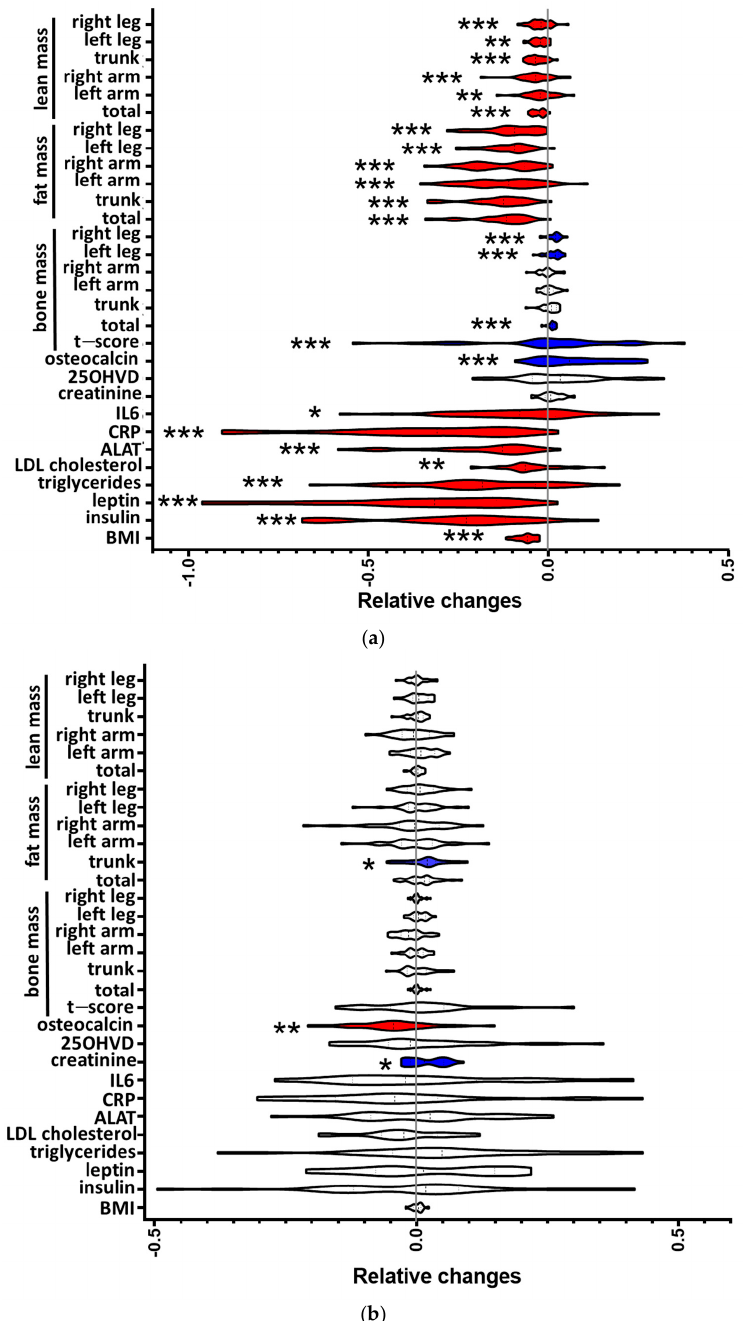
Figure 3. ( a ) Changes in body composition and clinical and laboratory parameters in participants of the intervention group. Violin plots of log ratios of given parameters before and after the 6-month intervention period. The Wilcoxon signed-rank test was used to analyze differences between paired samples; * p < 0.05; ** p < 0.01; *** p < 0.001. The grey line denotes baseline levels. The red color indicates a significant reduction while the blue color reflects a significant increase in the indicated parameter after the intervention period. ( b ) Changes in body composition and clinical and laboratory parameters in participants of the control group. Violin plots of log ratios of given parameters before and after the 6-month study period. The Wilcoxon signed-rank test was used to analyze differences between paired samples; * p < 0.05; ** p < 0.01. The grey line denotes baseline levels. The red color indicates a significant reduction while the blue color reflects a significant increase in the indicated parameter after the study